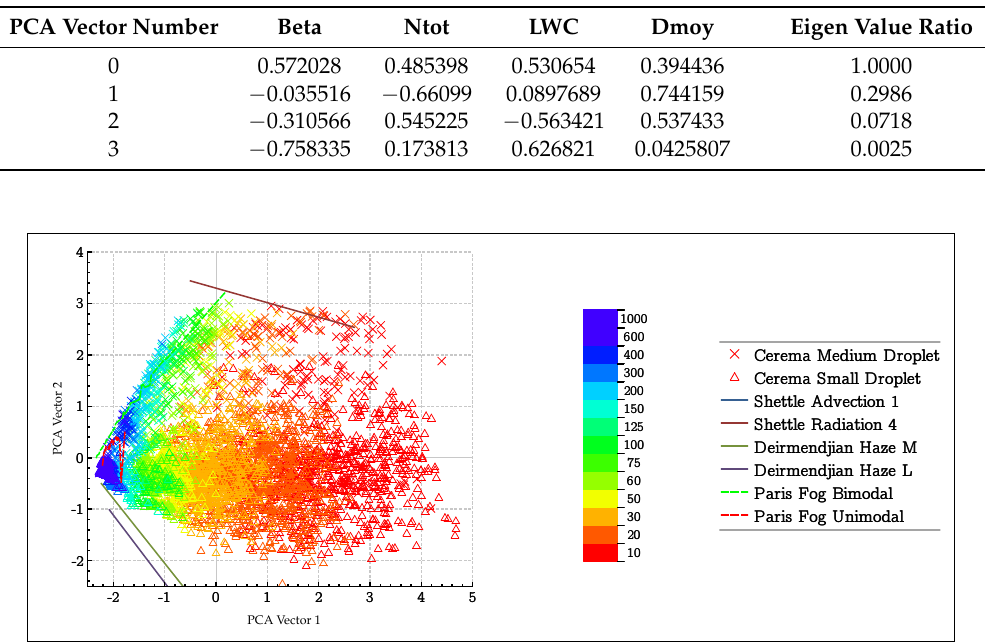
Table 3. Principal component analysis (PCA) results on conventional parameters.